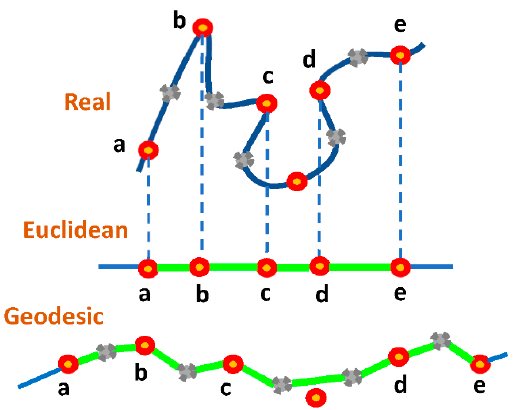
Figure 1. The concept of ISOMAP. The given data points are marked by a–e. Their neighbors are gray star points. The green segments are the measured distances of these data points.